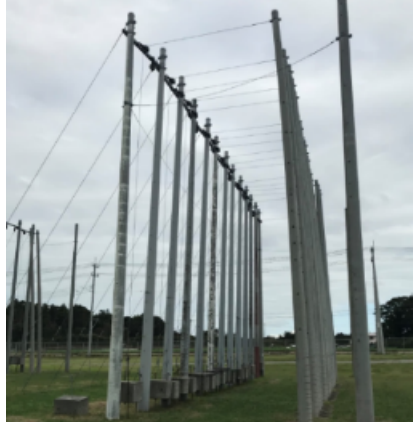
Figure 7. Exposure test of "CP350" utility poles at the Muroran test site in Japan (started in July